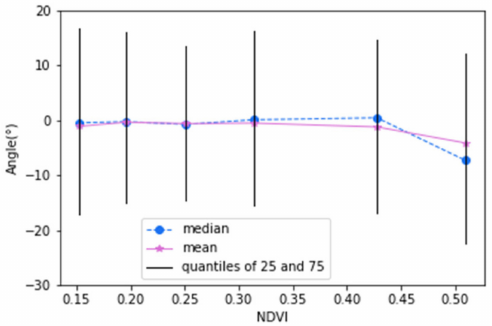
Figure 9. The skewing angle changes with vegetation cover in Yimin